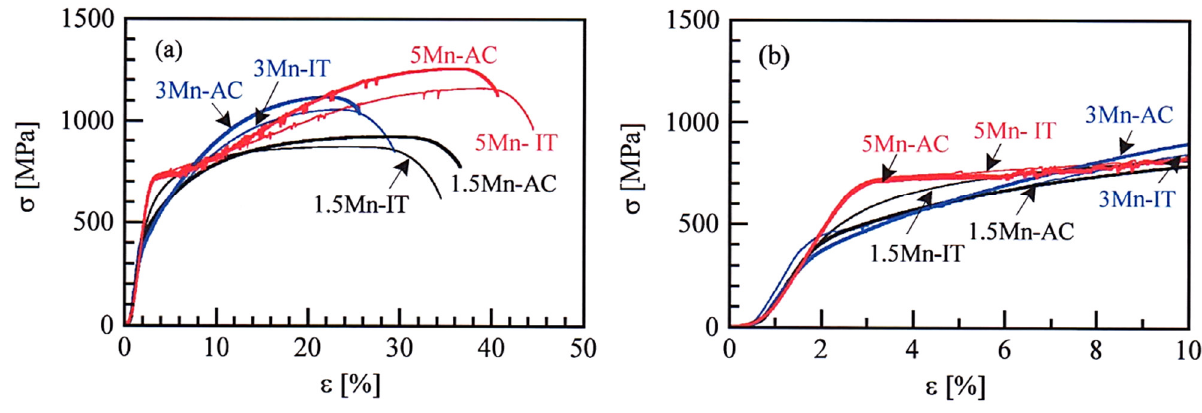
Figure 6. Engineering stress–strain ( σ - ε ) curves of ( a ) overall and ( b ) early strain ranges in the 1.5 Mn, 3 Mn, and 5 Mn steels subjected to the AC (thick lines) and IT (thin lines) processes.